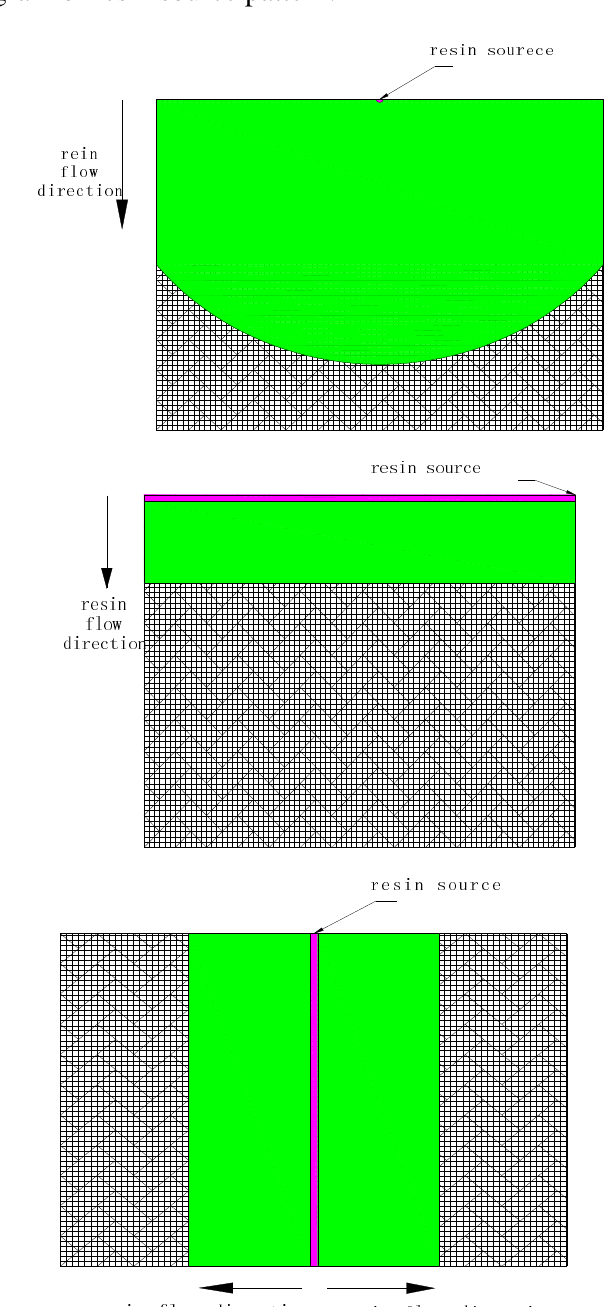
Figure 9. Schematic diagram of resin source